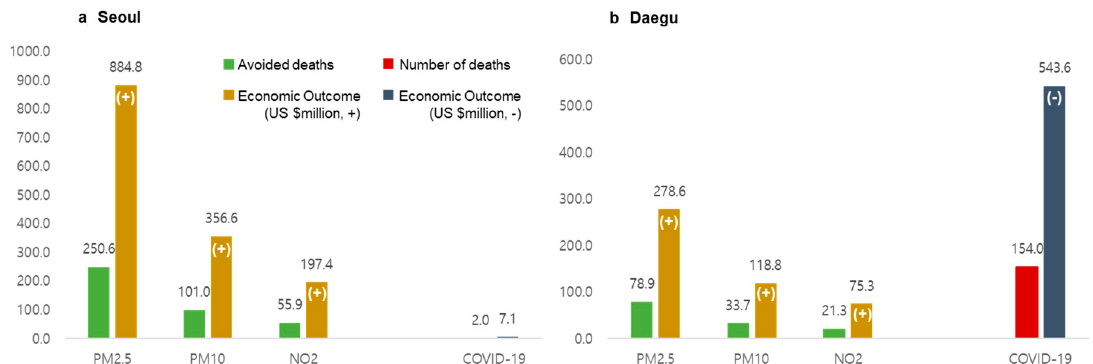
Figure 9. Avoided deaths from PM 2.5 , PM 10 , and NO 2 reductions over 18 weeks, and associated economic outcomes ( + ). The economic outcome from COVID-19 deaths was evaluated as (-). (( a ): Seoul and ( b ):